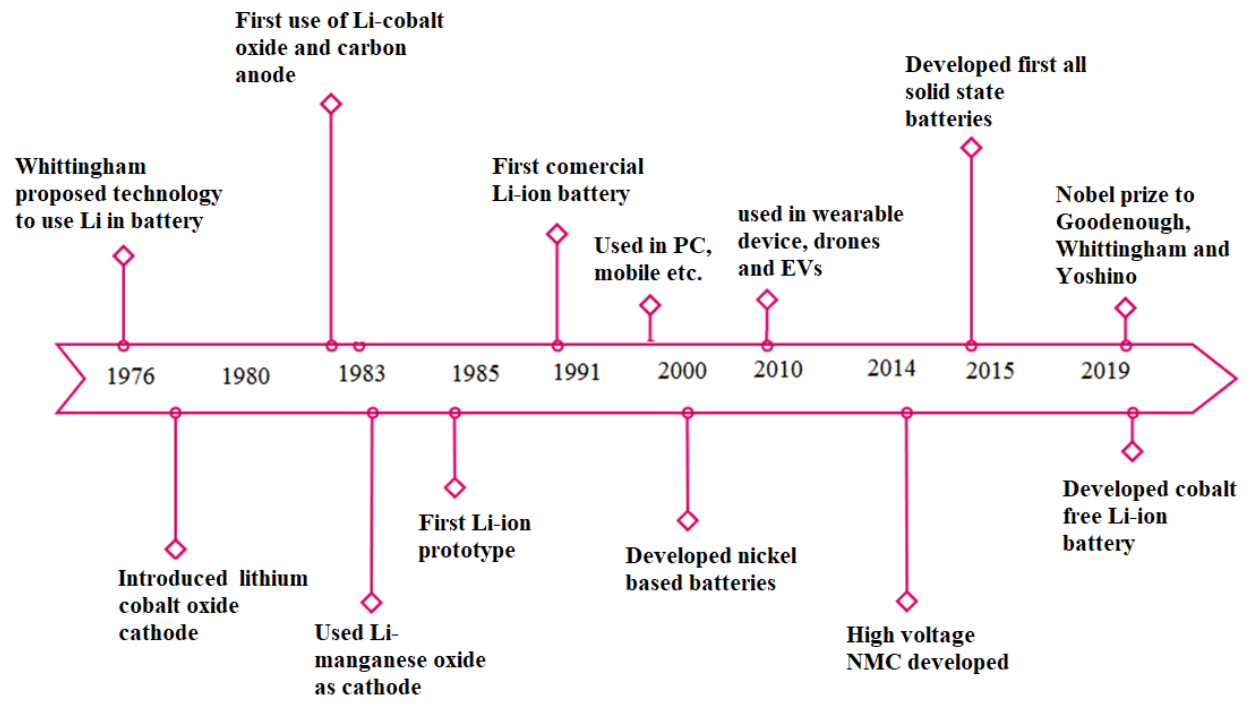
Figure 1. Major breakthroughs in LBs and its related